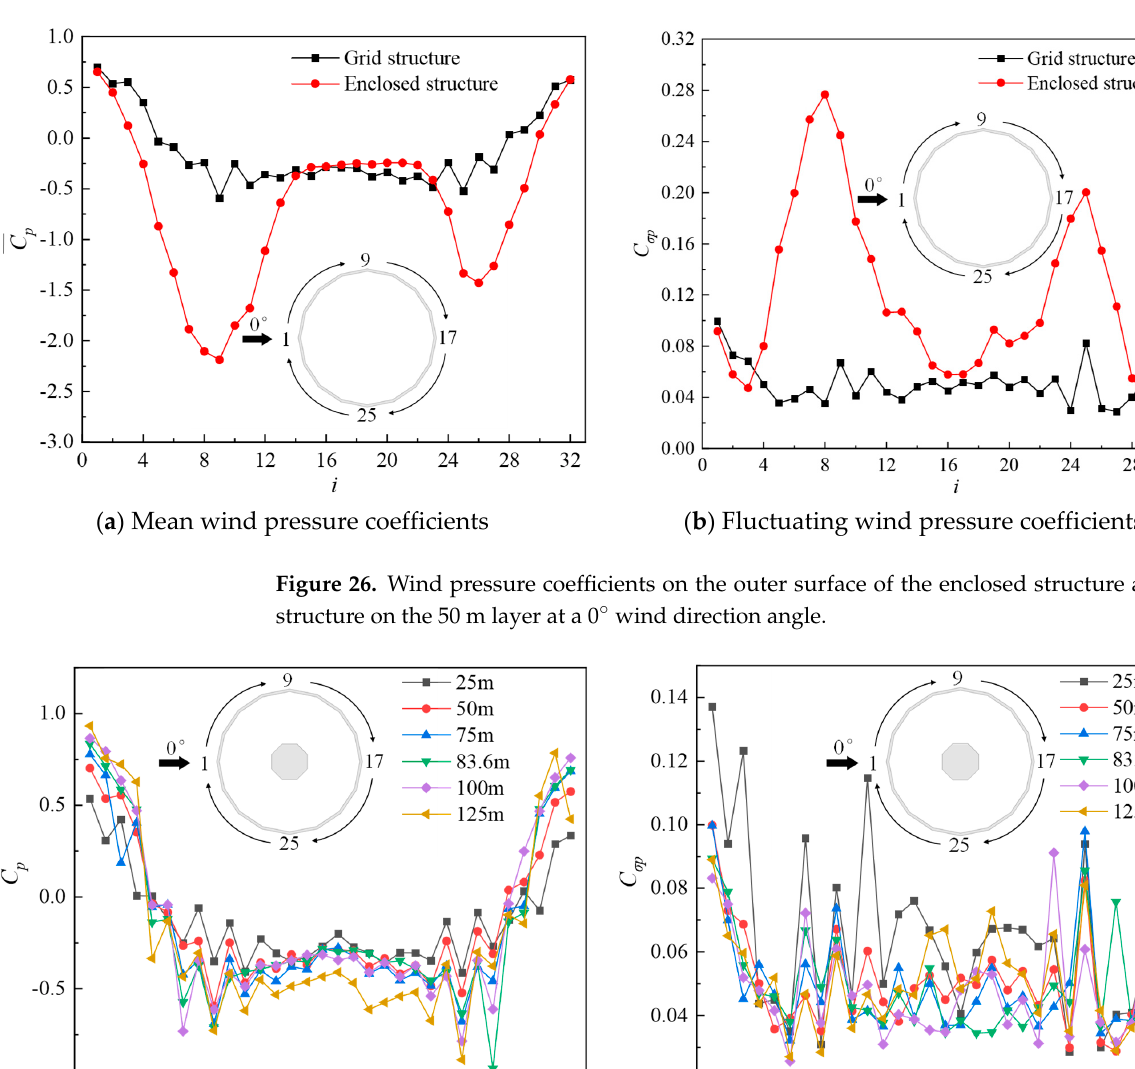
Figure 25. Fluctuating wind pressure coefficient distribution on the 50 m layer: ( a ) Windward side of the grid structure; ( b ) Windward side of the core tube; ( c ) Leeward side of the grid structure; ( d ) Leeward side of the core tube.